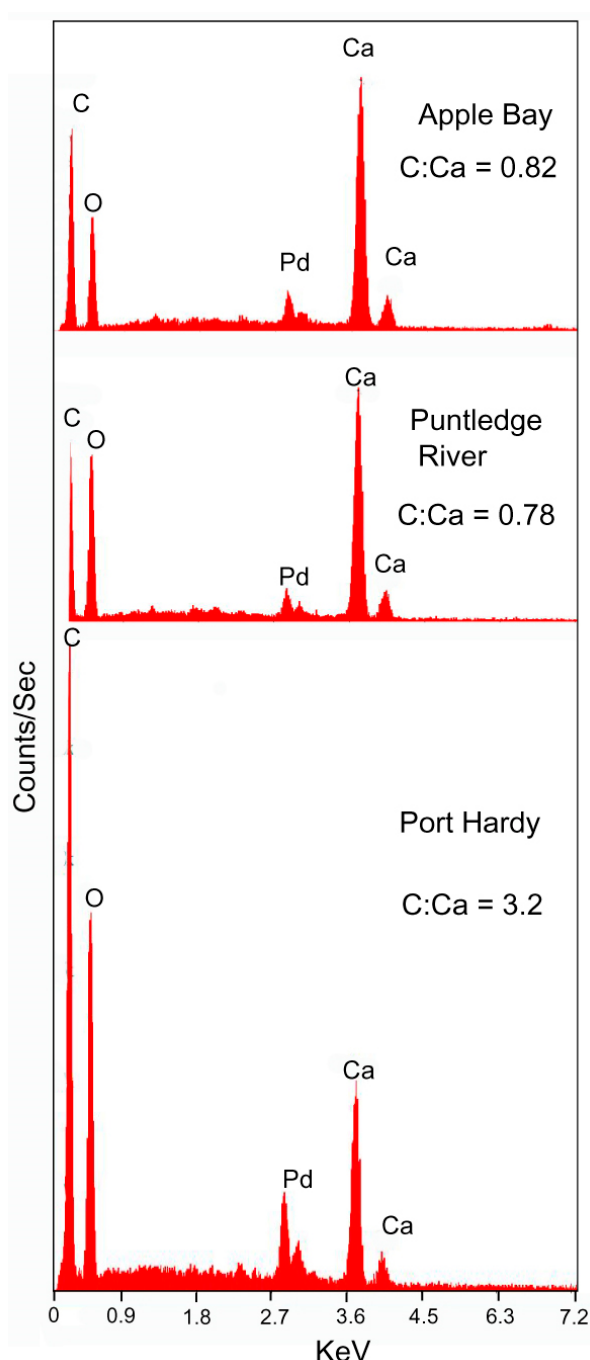
Figure 7. Energy dispersive X-ray fluorescence spectra. Pd peak is from coating applied to provide electrical conductivity. C:Ca peak height ratios provide an approximate indication of the abundance of relict organic matter.